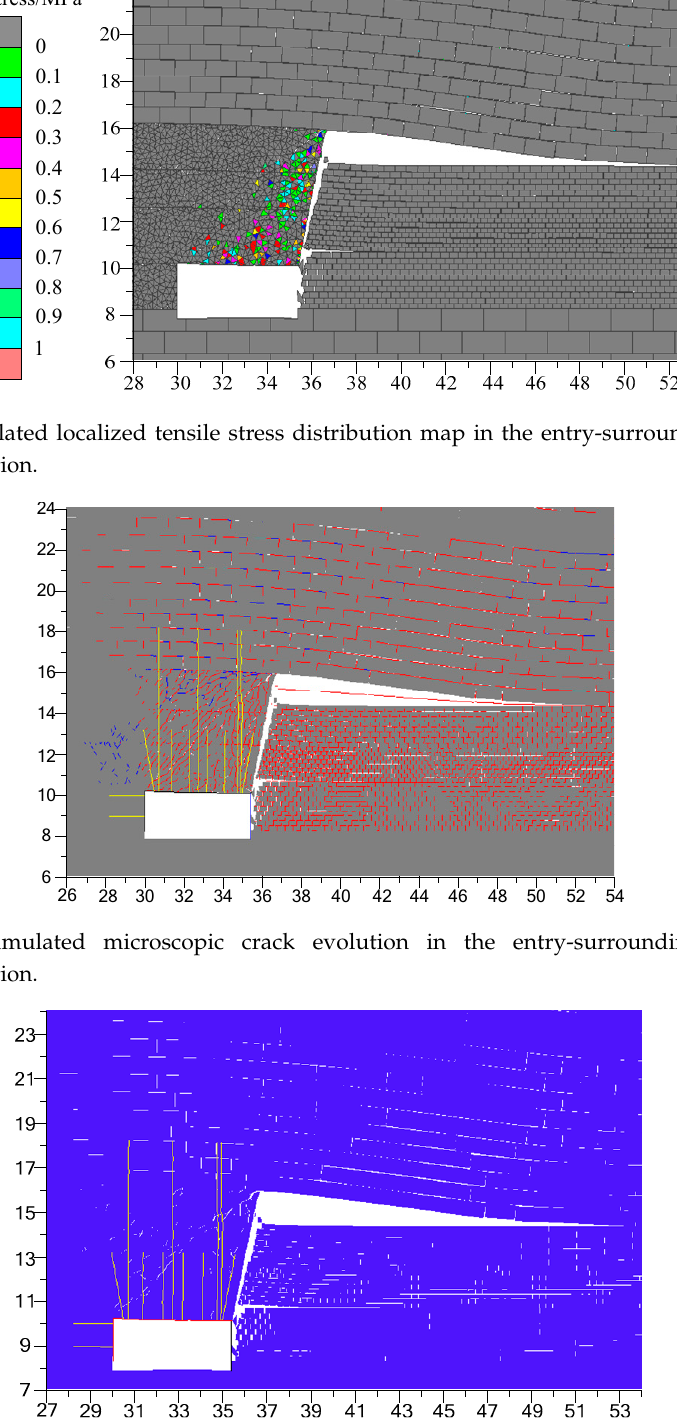
Figure 14. Simulated failure patterns of the entry in a supported condition.